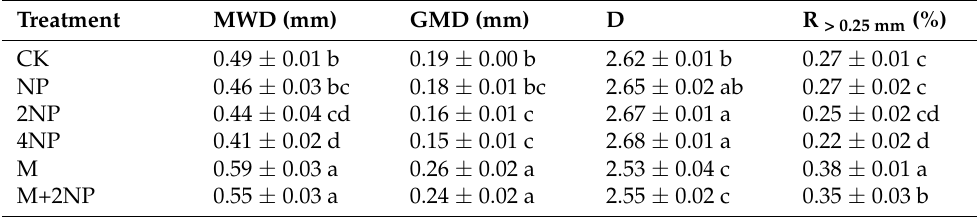
Table 2. Soil aggregate stability indexes.